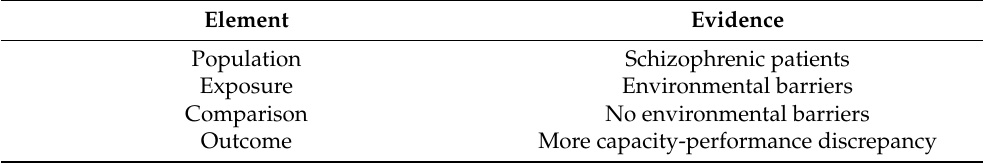
Table 1. PECO (Population, Exposure, Comparator, and Outcome) statement in this study.